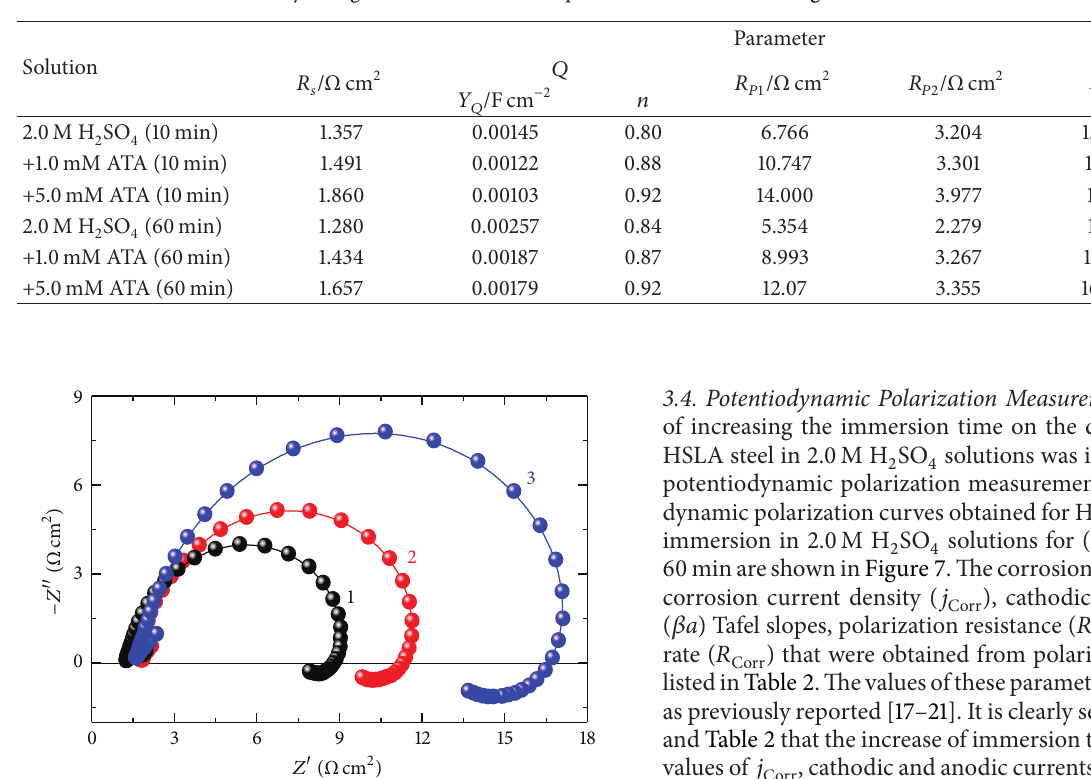
Figure 5: Nyquist plots for the HSLA steel after its immersion for 10min in 2.0 M H 2 SO 4 solutions in (1) the absence and the presence of (2) 1mM ATA and (3) 5mM ATA, respectively.